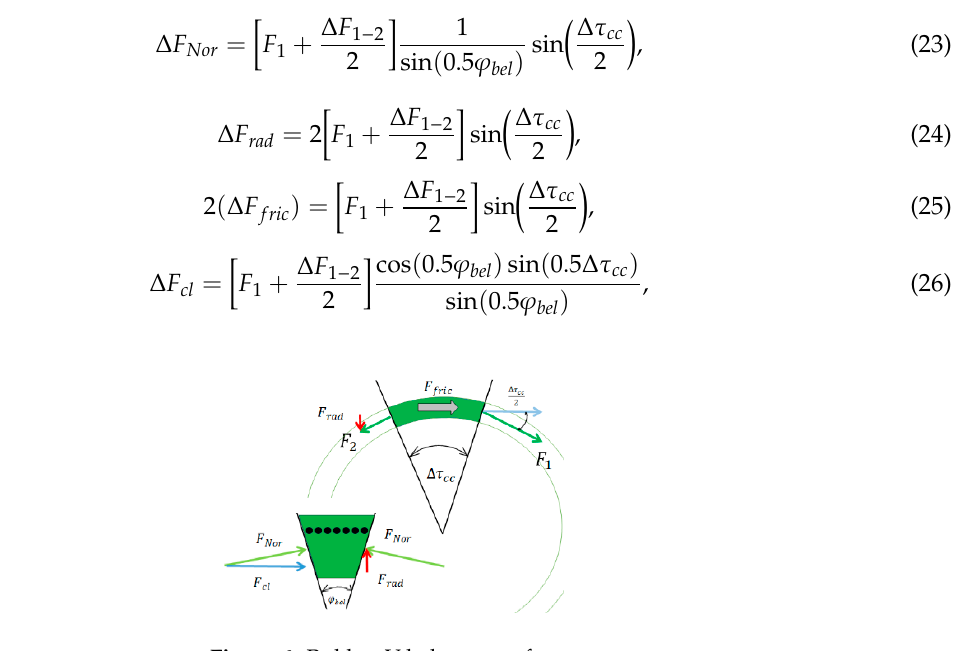
Figure 6. Rubber V-belt system forces.